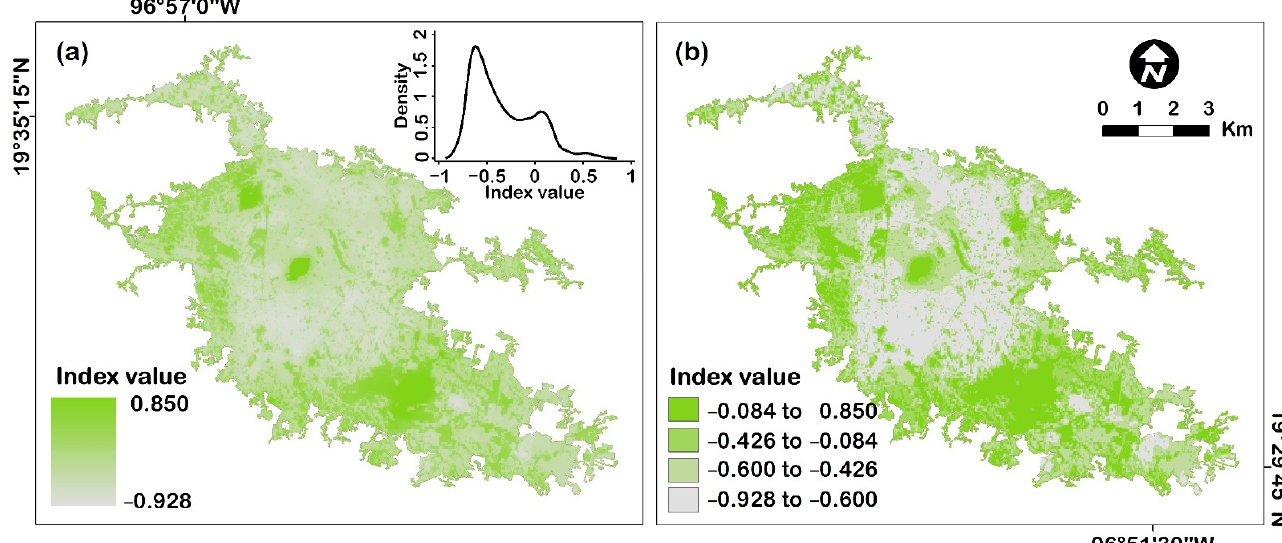
Figure 3. Spatially explicit representation of the Urban Ecosystem Integrity Index (UEII) in Xalapa (30 m × 30 m pixel resolution), showing ( a ) continuous results illustrating the distribution of the index values in a density plot and ( b ) its zoning by quartiles.